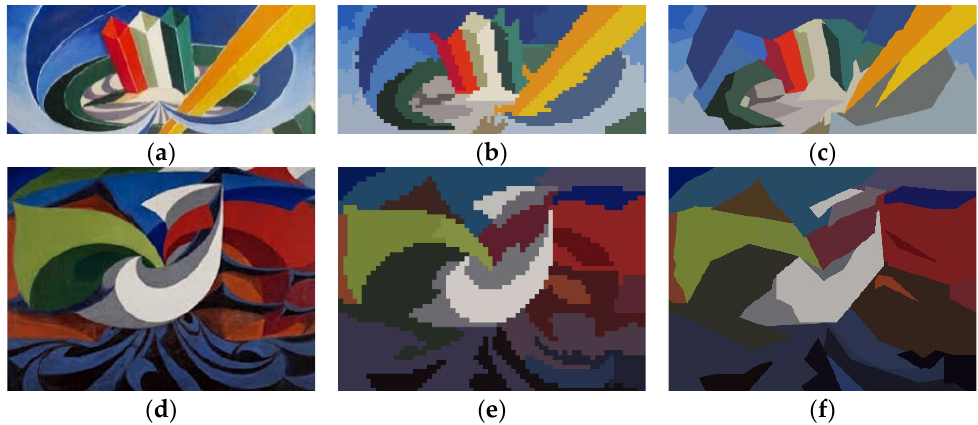
Figure 9. Two examples of image segmentation and region shape adjustment results. ( a ) An original image, “Canto patriottico-Piazza Siena”, by Giacomo Balla, 1915. ( b ) The result of image segmentation by region growing and merging of ( a ). ( c ) The result of region shape adjustment by polygon approximation of ( b ). ( d ) Another original image, “Forme grido Viva l’Italia,” by Giacomo Balla, 1915. ( e ) The result of image segmentation by region growing and merging of ( d ). ( f ) The result of shape adjustment by polygon approximation of each region of ( e ).